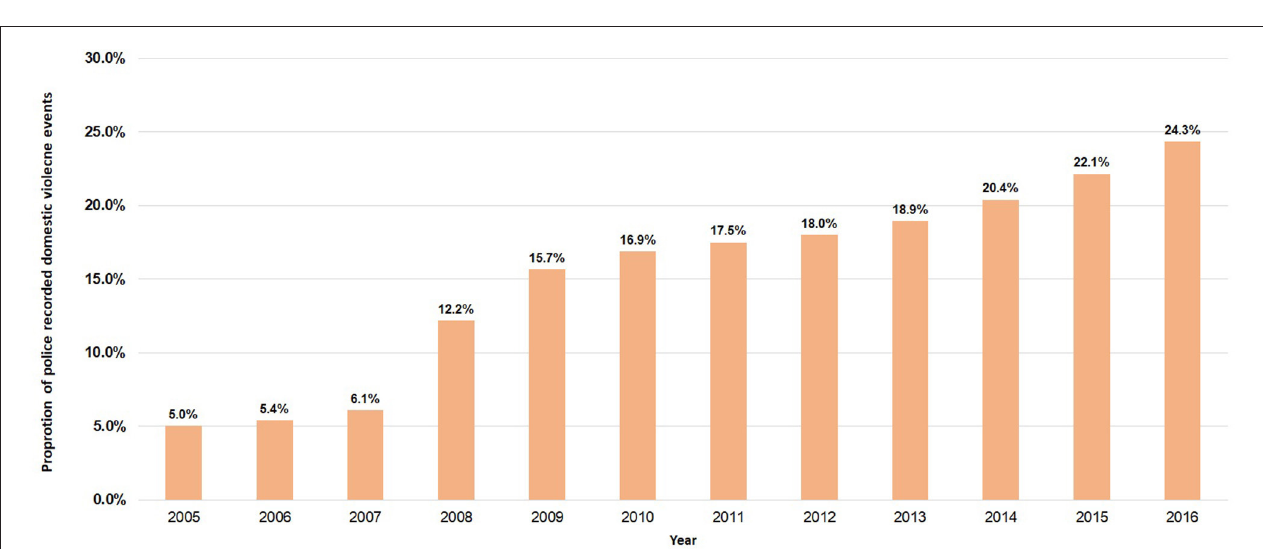
not recorded by current surveillance systems (5, 6). For